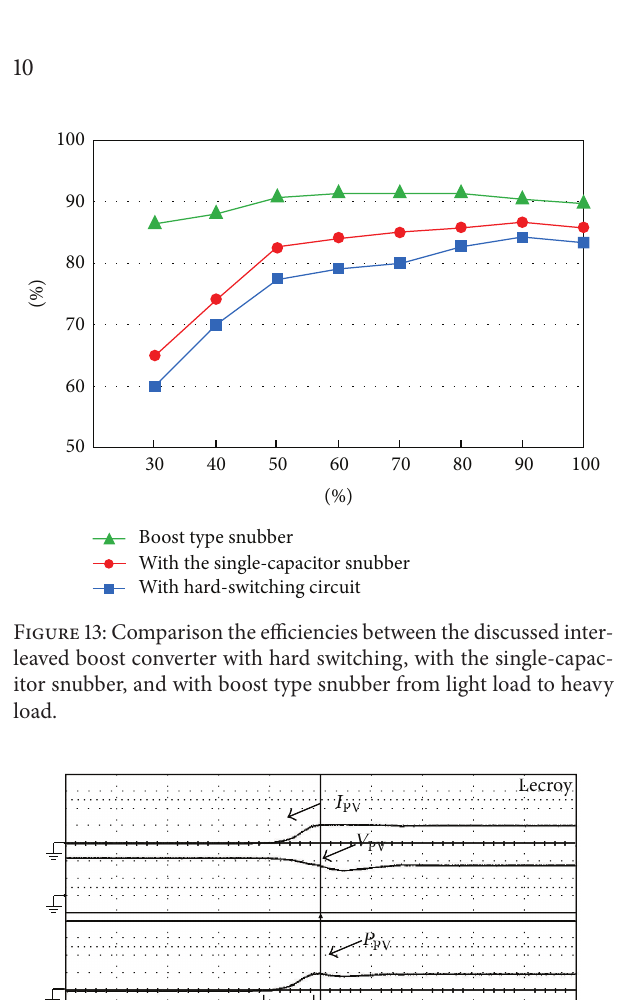
Figure 14: Measured voltage 𝑉 forms of the converter with PV arrays source and with the single- capacitor snubber under 𝑃